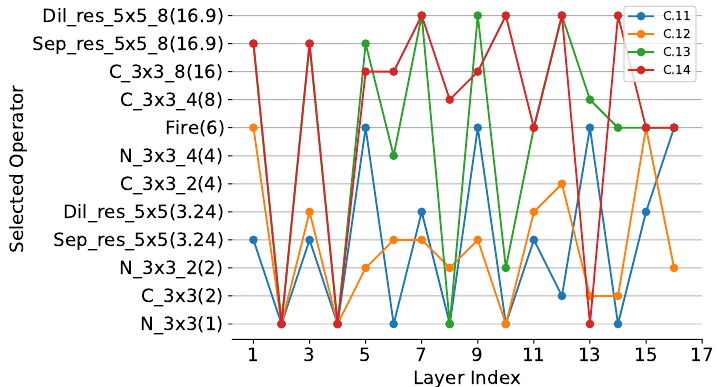
Figure 6. The operator of each layer in compressed ResNet18. The layers in the figure do not include the first convolutional layer and the last fully connected layer. The vertical axis has the same meanings as Figure